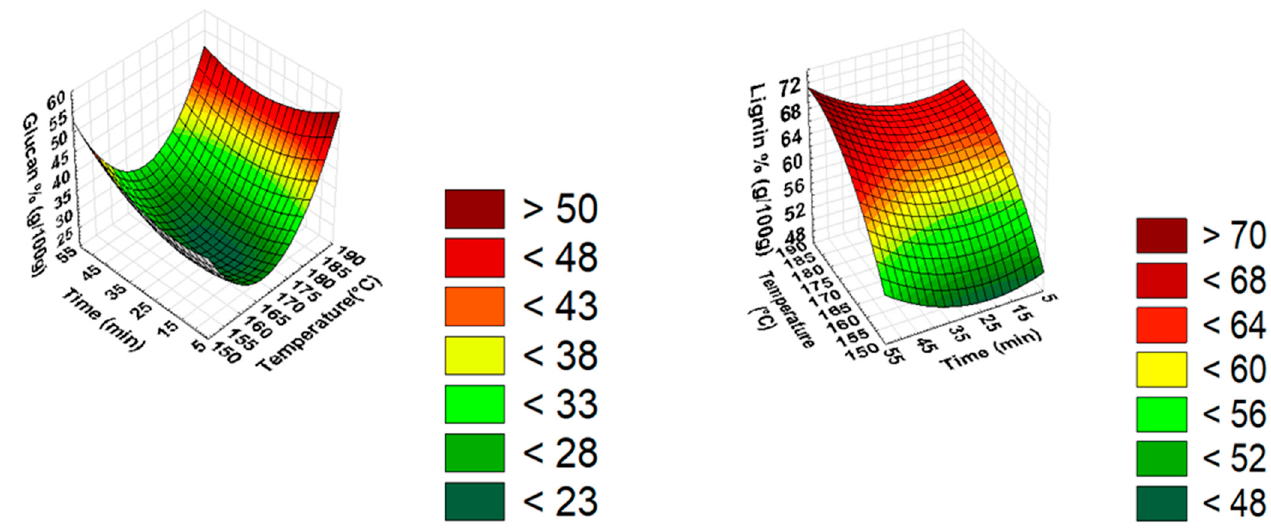
Figure 1. Effect of temperature and time on glucan and lignin percentage (g/100 g).